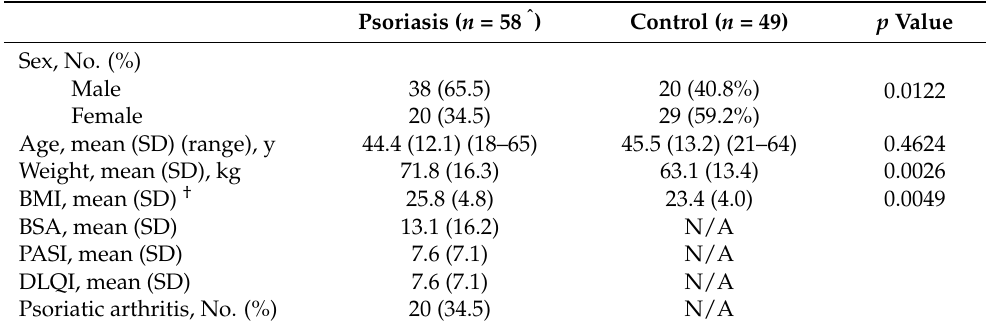
Table 1. Baseline demographic and disease characteristics of